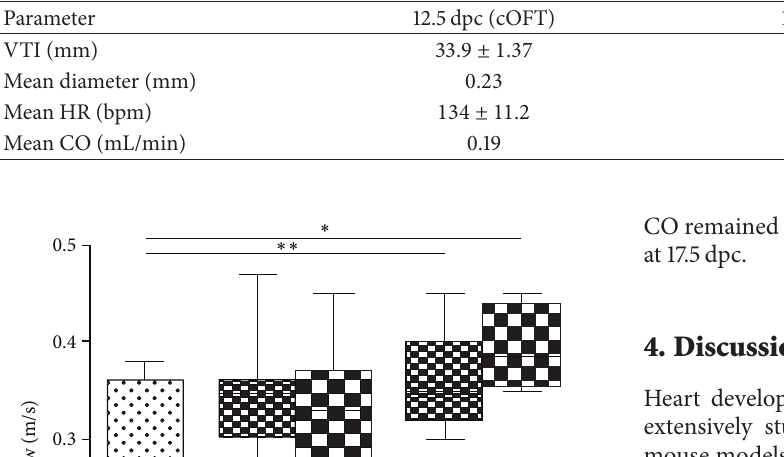
Table 3: The parameters used for calculation of the mean CO per gestational age.